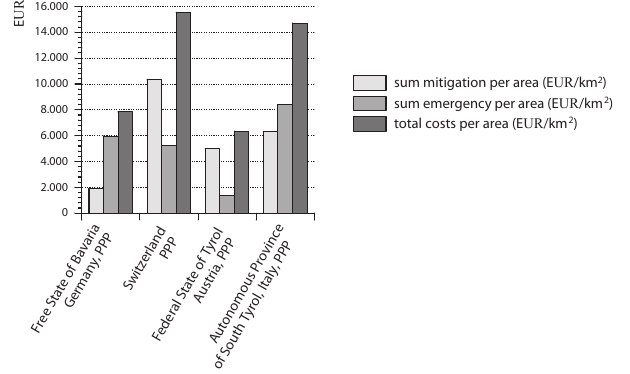
Fig. 4. Per area expenses for mitigation, emergency and total costs for public safety in km 2 (in EUR PPP values, reference years: 2007–